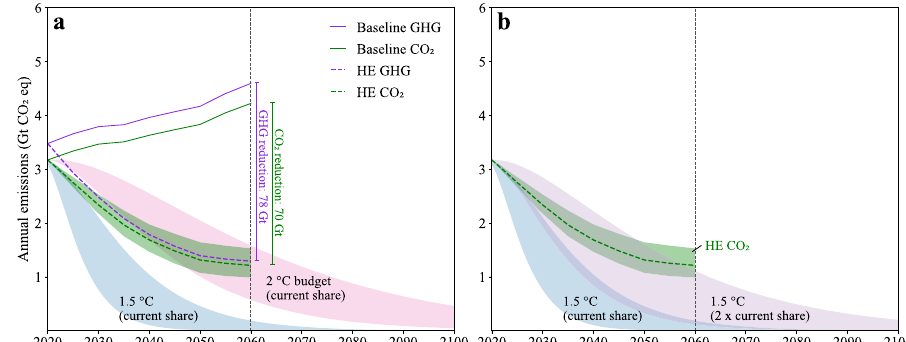
Fig. 3 Building-material related emissions in the Baseline and High Ef fi ciency (HE) scenarios compared with the 1.5/2 °C-compatible mitigation pathways. a Greenhouse gas (GHG) emissions compared with the 1.5/2 °C-compatible mitigation pathways where the building material sector shares a proportional global carbon budget at 7.5%. b CO 2 emissions compared with the 1.5°C-compatible mitigation pathways where the building material sector sees a doubling share of the global carbon budget. The shaded bands in green represent the sensitivity intervals of CO 2 emissions in the HE scenario (as de fi ned by 20 percentage point variations for each strategy, for more details see Supplementary Table 13). Other shaded areas represent the assessed range for the GHG emission pathways of the building material sector that are consistent with the 2 and 1.5 °C climate targets according to the IPCC, respectively, for the 33 – 67th percentile of TCRE (the transient climate response to cumulative carbon emissions (see Methods